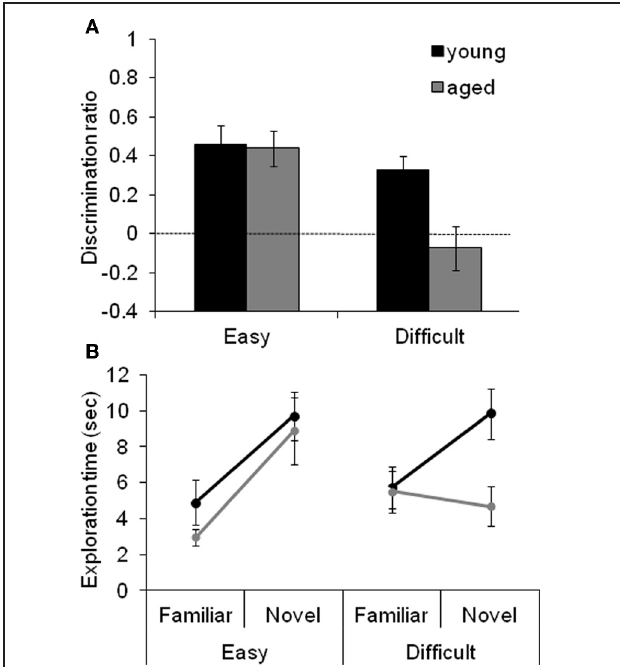
FIGURE 4 | The effect of difficulty on SOR task performance. (A) The mean discrimination ratio of the adult (black) and the aged rats (gray) measured during the test phase following a 30s delay for the “Easy” and “Difficult” conditions. A higher discrimination ratio indicates that the animal spent more time exploring the novel object relative to the familiar object. The aged rats had significantly smaller discrimination ratios when compared to the adult rats for the Difficult condition, but not for the Easy condition. The dashed horizontal line indicates chance performance. (B) The mean amount of time young (black) and aged (gray) rats spent exploring the familiar and the novel object during the different testing conditions. Compared to the young animals, the aged rats spent significantly less time exploring the novel object during the test phase of the Difficult condition. In contrast, novel exploration between age groups was similar during the Easy condition. Error bars represent ± 1 standard error of the mean (reprinted with permission Burke et al., 2011).